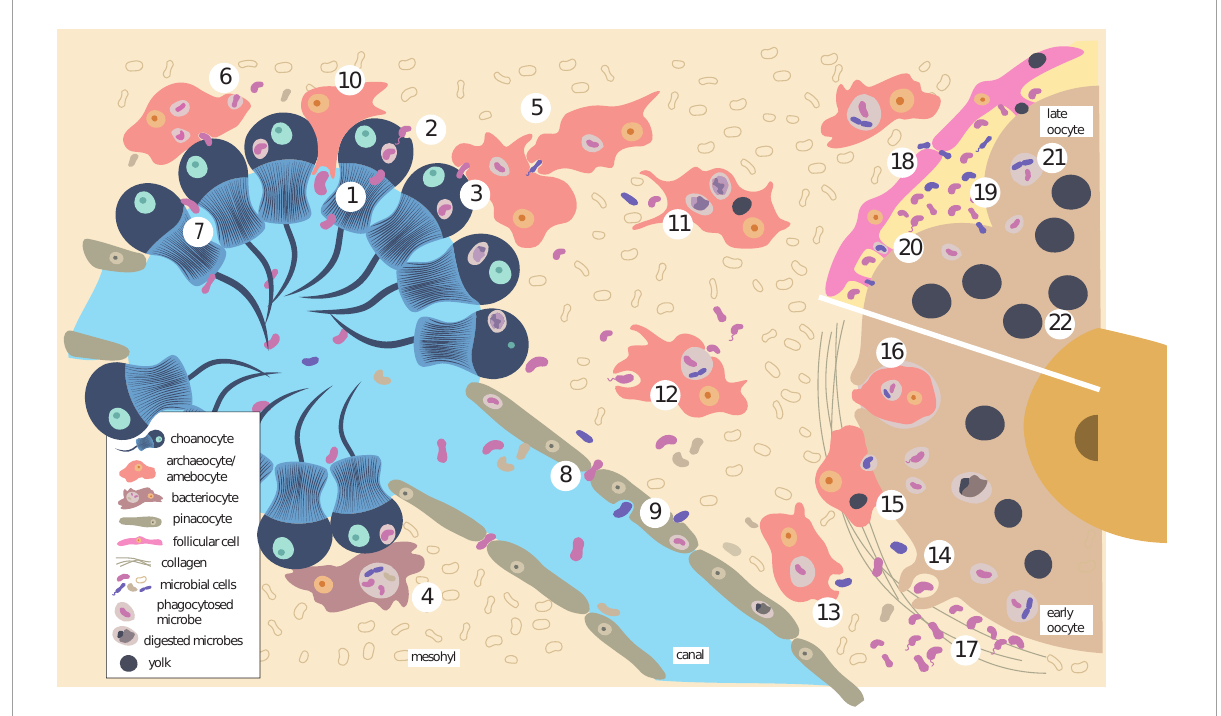
FIGURE3 Methods of acquisition and transmission of symbiotic bacteria to oocytes in sponges. Horizontal acquisition through filtering by choanocytes (1) that are then engulfed in vesicles and released in the mesohyl (2), transferred to amebocytes/archaeocytes (3), or bacteriocytes (4). Amebocytes/archaeocytes can either transfer the microbial cells to other host cells (5) or to the mesohyl (6). In some cases, microbial cells can squeeze in-between choanocytes (7) or pinacocytes (8) toward the mesohyl. Pinacocytes can also phagocytose microbes from the canals (9) and release them to the mesohyl. Bigger cells can be engulfed by amebocytes that reach the choanocyte chambers through the spaces between choanocytes (10). Amebocytes/archaeocytes can either digest the microbes (11) or store them intact within vesicles (12). The symbionts within amebocytes/archaeocytes are sometimes released close to the oocyte (13), that will phagocytose them subsequently (14), or can be transferred by fusing the membranes (15), acting then as nurse cells. In some cases, the nurse cells are phagocytosed completely by the oocyte (16). Microbes can also approach the oocyte by the mechanisms described in the text, and accumulate there (17). Once the oocyte is fertilized, some microbes penetrate the space between the follicle and the egg before its closure (18), and then can enter the embryo through the cleavage furrow (19), or be transferred by the follicle cells using cytoplasmic bridges (20). Depending on the species or reproductive stage, microbes are maintained intact (21) or digested to form yolk